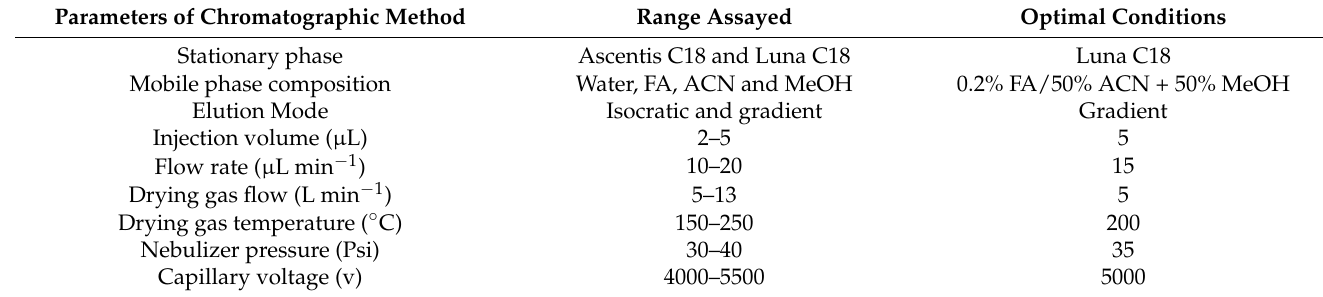
Table 2. Optimised operating conditions for the determination of natural porphyrins in hair by CLC-MS.